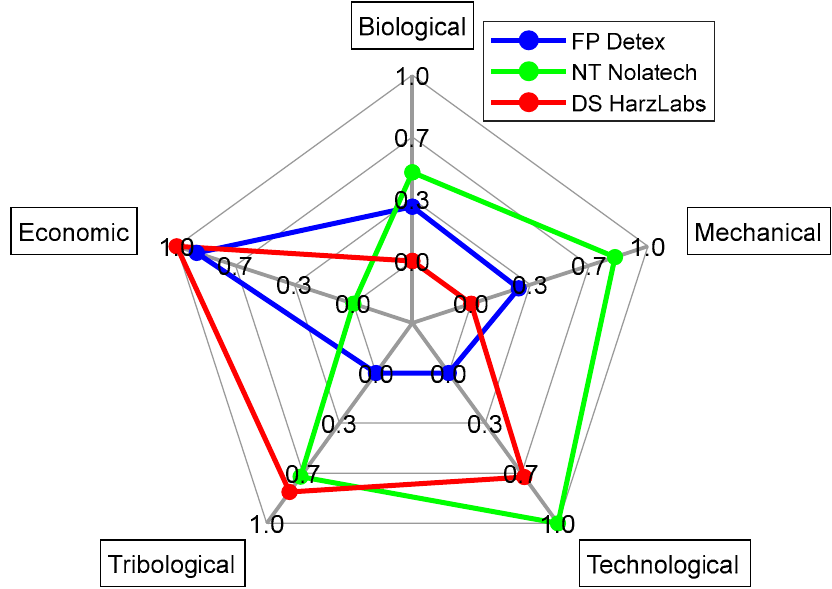
Figure 3. A radial diagram of Q 1 calculation by the groups of the factors.